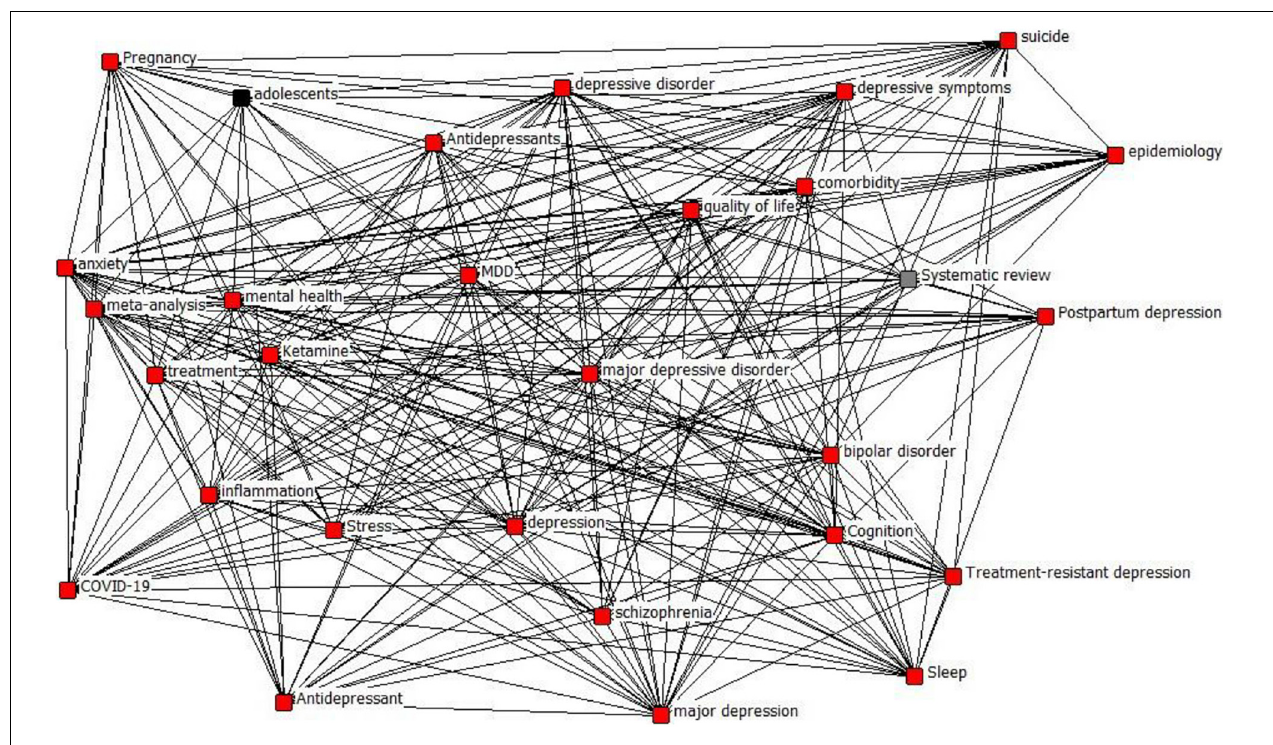
FIGURE 4 | Node K-core value stratification.